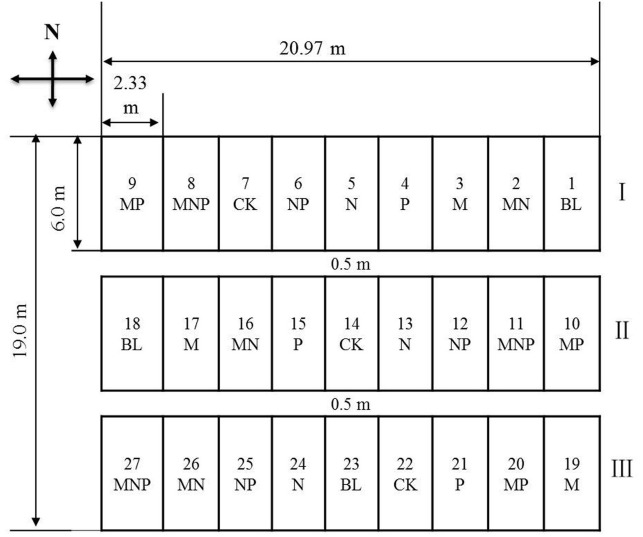
Scheme showing the experimental area with various fertiliser treatments.Note: Mineral fertilizers were nitrogen (N) and phosphorus (P), organic fertilizer was farmyard manure (M). Treatments were mineral fertilizers, organic manure, different combinations of mineral fertilizers and organic manure, unfertilized bare land (BL) and an unfertilized control (CK).